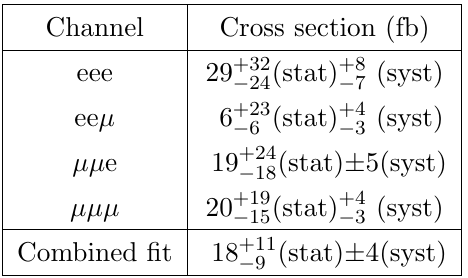
Table 5 . The measured cross sections for the individual channels and the channels combined for the counting